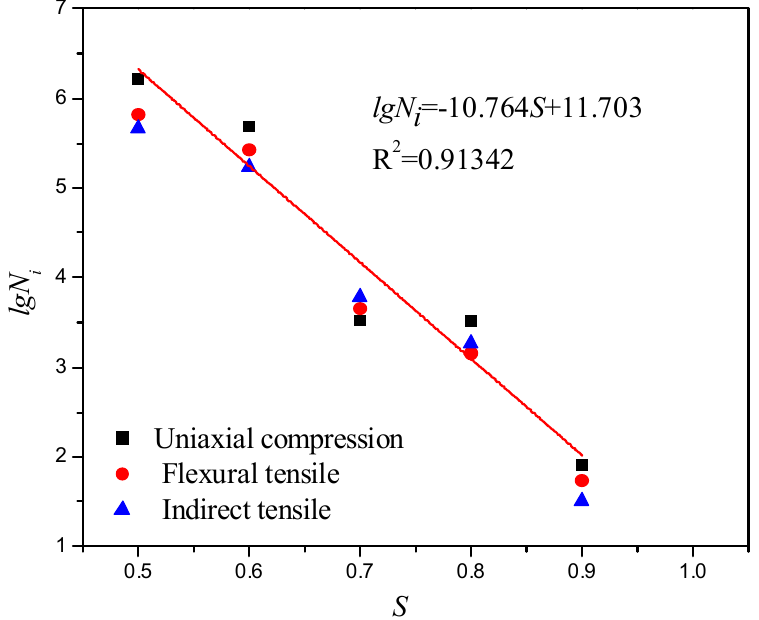
Figure 11. Standardization equations for fatigue properties with a cement content of 5% at a curing time of 28 days and a guaranteed rate of 95% under different stress states.